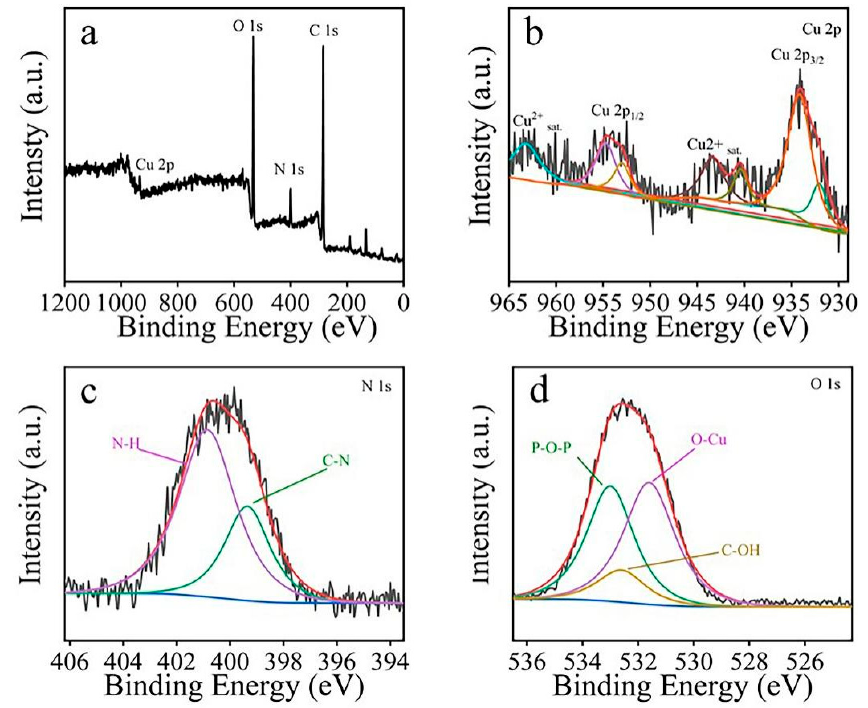
Figure 2. ( a ) XPS full spectra of APP-Cu@PDA, ( b ) Cu 2p, ( c ) N 1s, and ( d ) O 1s. In order to further confirm PDA and Cu 2+ -modified APP, the obtained APP and APP- elemental composition. Figure 3a showed that the surface structure of APP was relatively smooth. After modification by Cu 2+ and PDA, the surface became rough. The combination of SEM and mapping images of the selected area proved the existence of Cu 2+ , N, and O elements, indicating that Cu 2+ and PDA were successfully coated on the surface of APP.